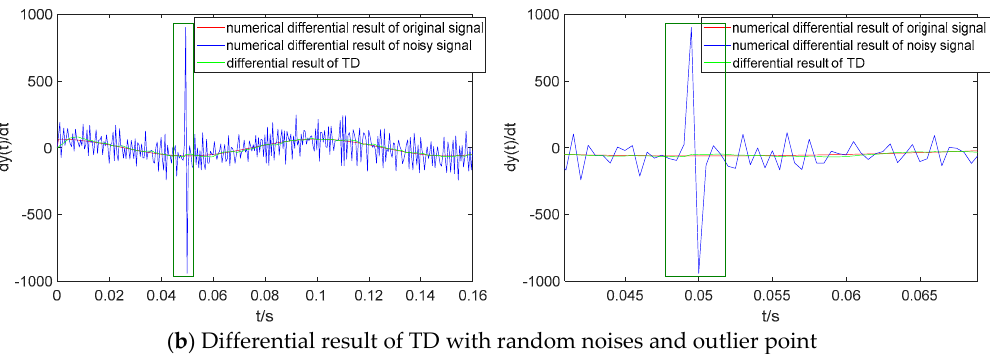
Figure 4. Filtering result and differential result of TD with random noises and outlier point.